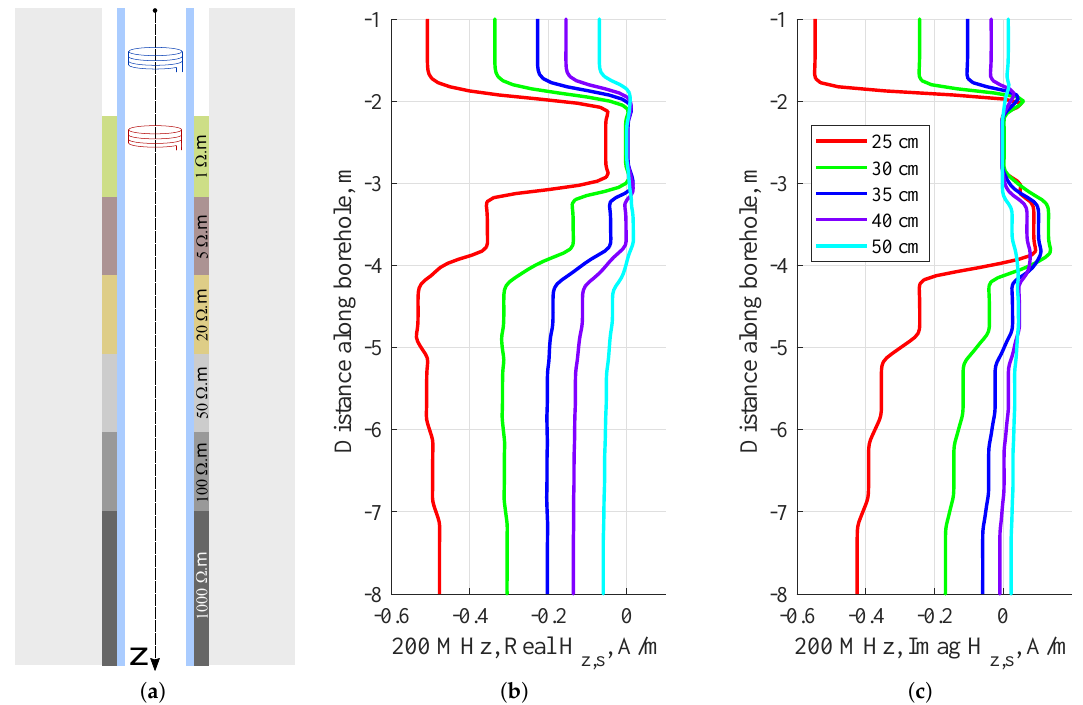
Figure 10. ( a ) The wellbore model with different resistivities of the cement (different solidification states) and induction logging signals at the frequency of 200 MHz for ( b ) real and ( c ) imaginary part of H z , s . Different tool lengths are